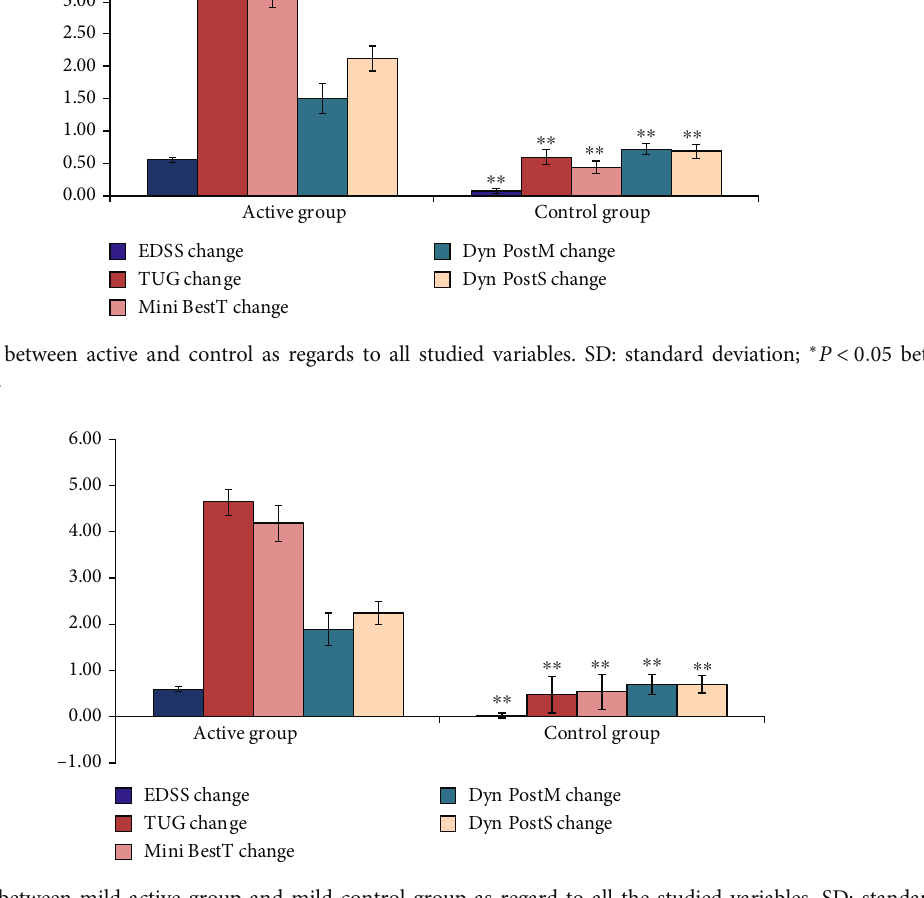
Figure 2: Comparison between mild active group and mild control group as regard to all the studied variables. SD: standard deviation; ∗ P < 0 : 05 between group comparison; ∗∗ P < 0 : 01 .